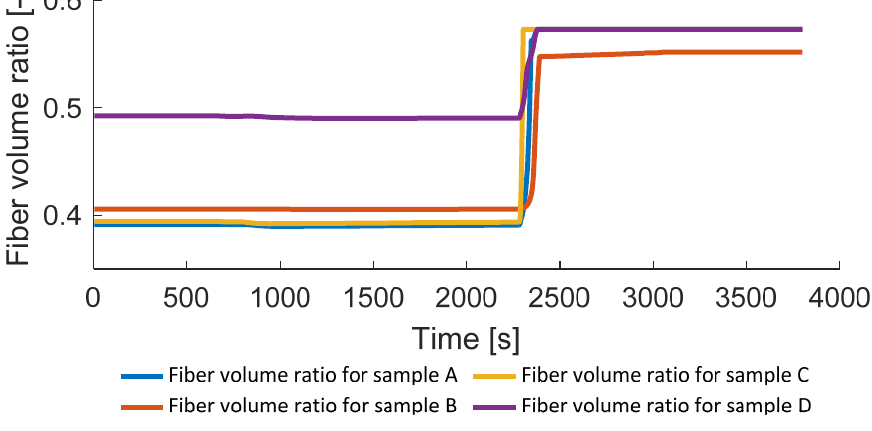
Figure 18. Fiber volume ratio.